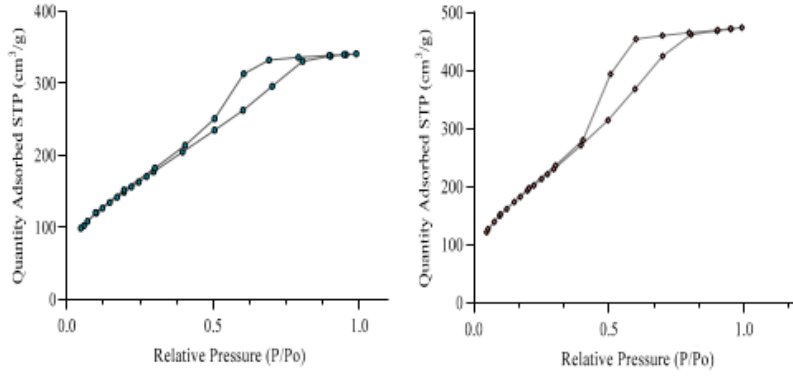
Figure 7. N 2 adsorption-desorption isotherms Blank@ORMOSIL ( left ) and 1.0% ZVI@ORMOSIL ( right